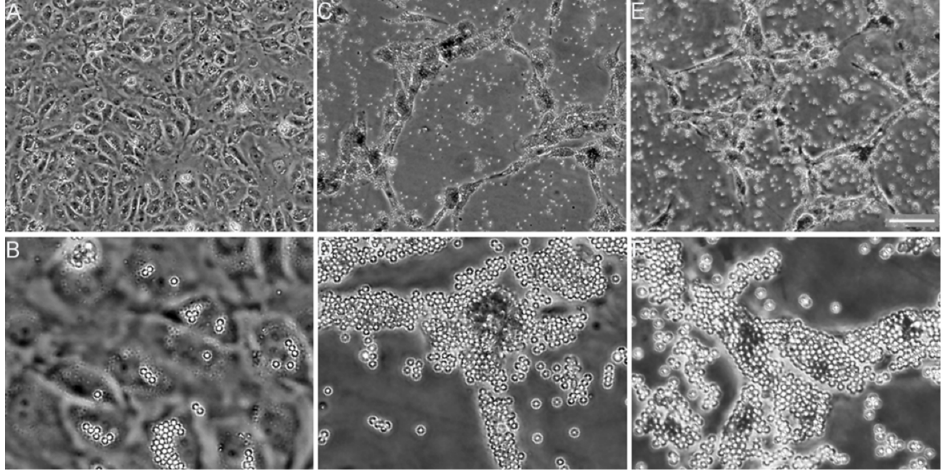
Figure 10. Anti-integrin antibody coated beads induce angiogenesis in the absence of collagen. Endothelial cells were exposed to 0.5 × 10 7 beads/cm 2 polystyrene beads (3 µ m diameter) coated with bovine serum albumin as a negative control ( A , B ), anti- α 2 β 1 integrin antibodies ( C , D ), and collagen ( E , F ). At 24 h, monolayers were rinsed and photographed. BSA beads showed no activity ( A ) and interacted with cells poorly ( B ). Anti- α 2 β 1 integrin antibody-coated beads induced tube formation similar to that of an apical collagen gel (( C ), see Figure 9) and interacted extensively with cells ( D ). Collagen- coated beads induced angiogenesis ( E ) and also interacted extensively with cells ( F ). Top row: Bar = 100 µ m. Bottom row: 20 × objective. Bead diameters = 3 µ m. Reprinted with permission from